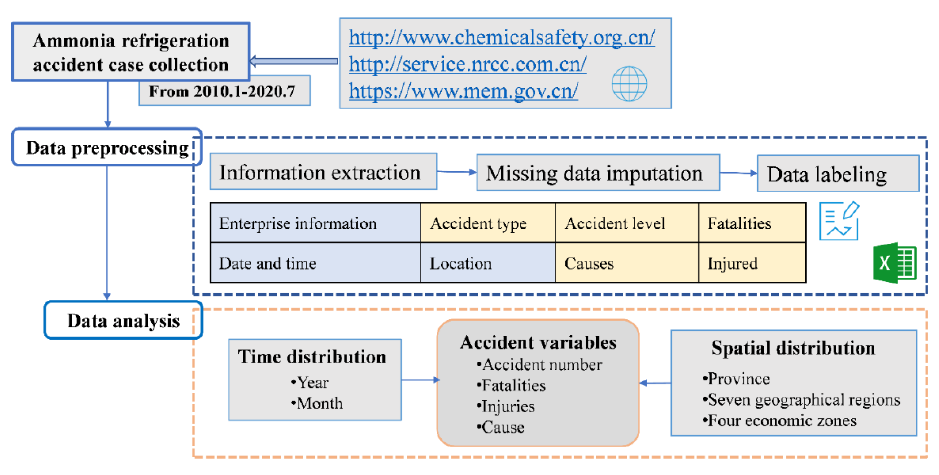
Figure 1. Research Figure 1. Research flowchart.